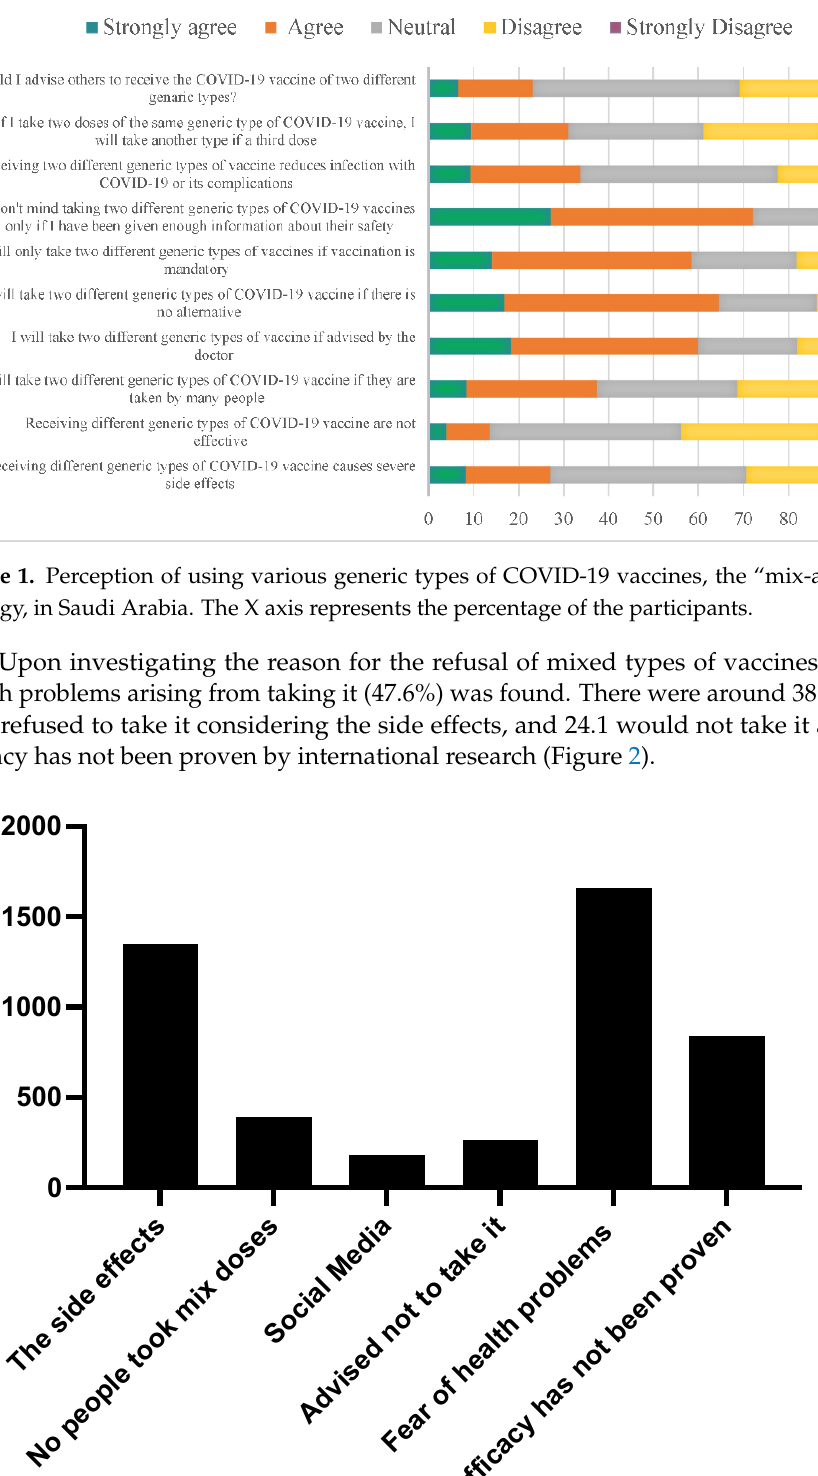
Figure 2. The reasons for participants to use different generic types of COVID-19 vaccines, the “mix-and-match” strategy, in Saudi